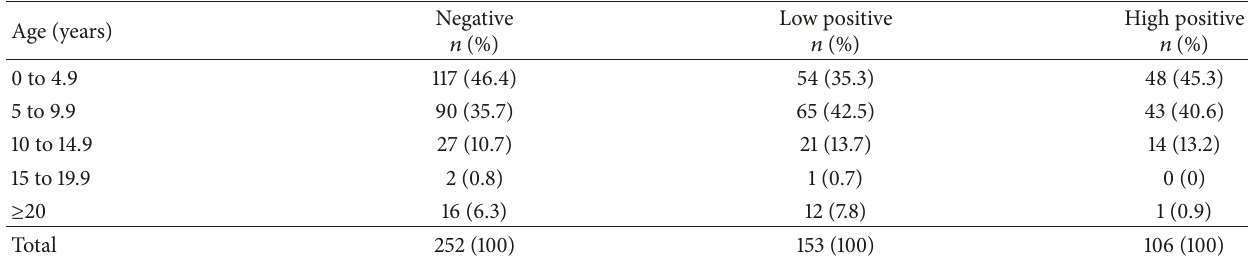
Table 3: Description of the study population by serology and age groups.